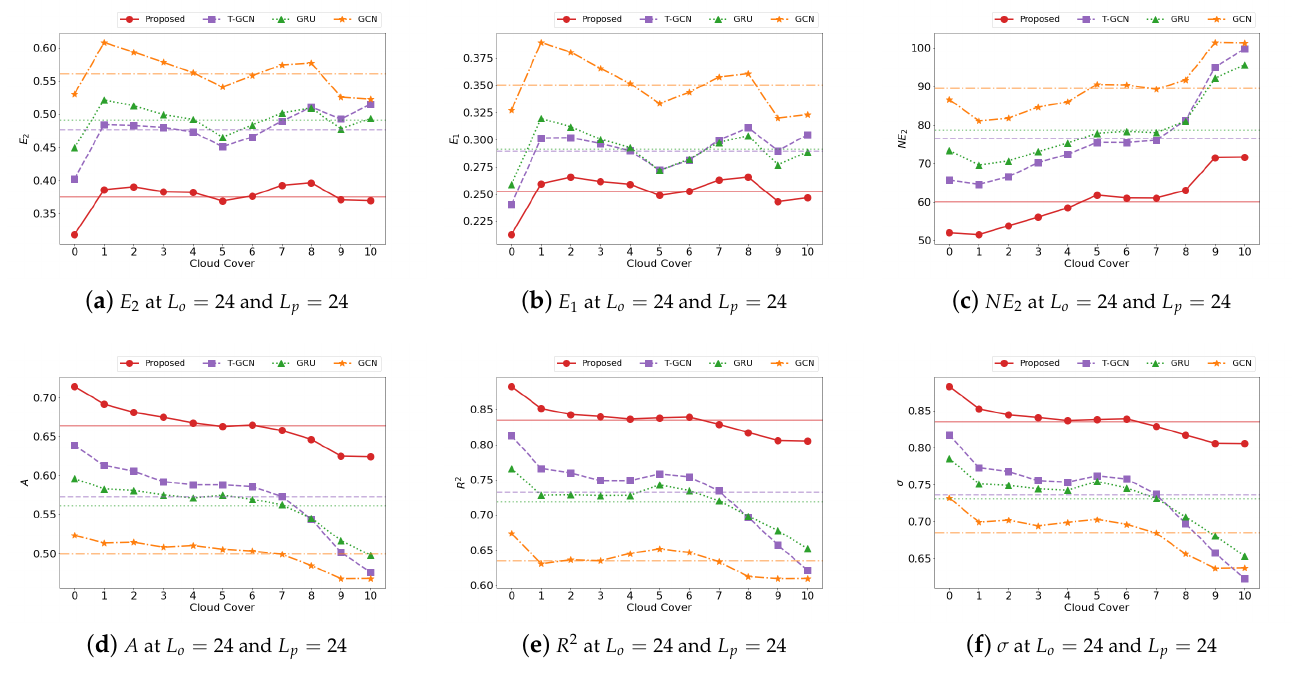
Figure A4. A comparison of the performance stability of the proposed model with the existing models according to the cloud cover. X-axesof the plots indicate the cloudiness level, and Y-axes correspond to the evaluation metrics. The translucent horizontal lines indicate average performance of the models.